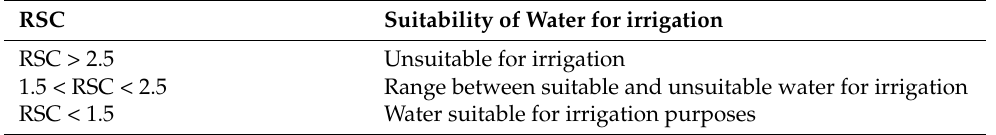
Table 4. Suitability of water for irrigation purposes according to RSC.